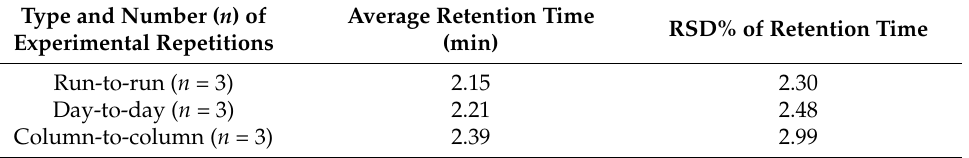
Table 2. The stability of retention behaviour of the prepared HFSNP monolithic column with 50 µ m ID at 80/20% ACN/H 2 O flow rate; 400 nL/min, 12 cm × 20 µ m i.d., concentration; 0.2 µ